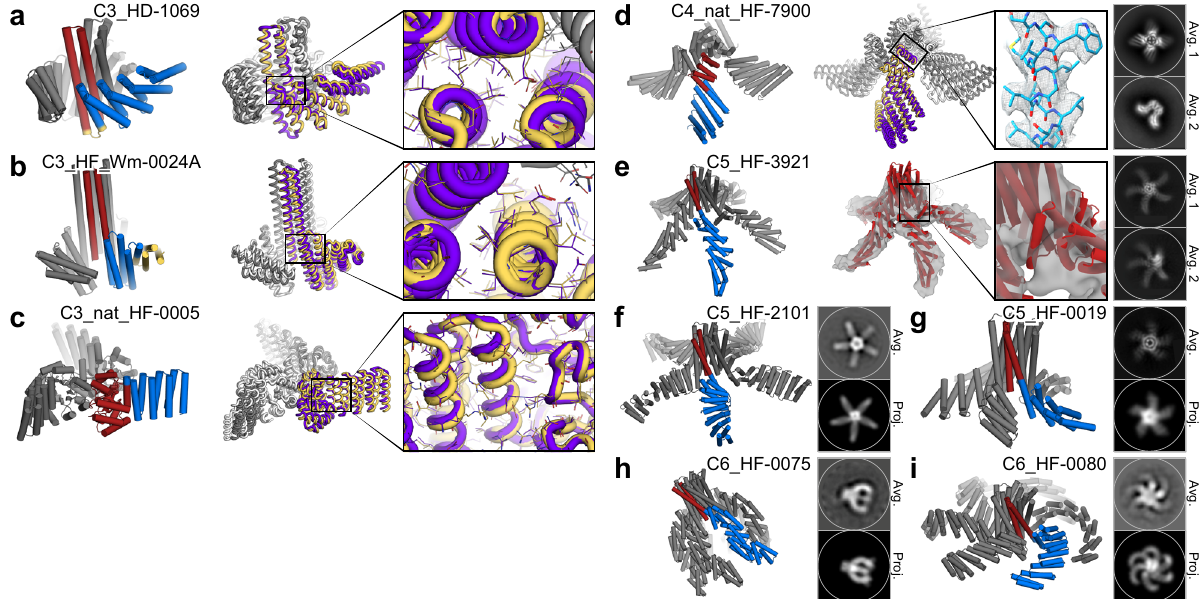
Fig. 2 Homo-oligomer diversi fi cation by repeat protein fusion. One central oligomer unit is shown in red and fused DHR in blue while other symmetrical units in grey. HelixDock (HD); HelixFuse (HF). a C3_HD-1069, with designed loop shown in yellow, b C3_HF_Wm-0024A, with additional WORMS fusion shown in yellow), and c C3_nat_HF-0005. Overlay of the design model (purple/gray) and crystal structure (yellow/white) shows the overall match of the backbone. Inset shows the correct placement of the rotamers in the designed junction region. d C4_nat_HF-7900; design model (purple/grey) and cryo- EM map (yellow/white), with insert highlighting the the high resolution (~3.8 Å) density. e C5_HF-3921 as characterized by cryo-EM, with inset showing density surrounding the designed junction. f C5_HF-2101, g C5_HF-0019, h C6_HF-0075, and i C6_HF-0080 all showed a good overall match to its negative-stain EM 2D class averages (top) from one direction, using a predicted projection map